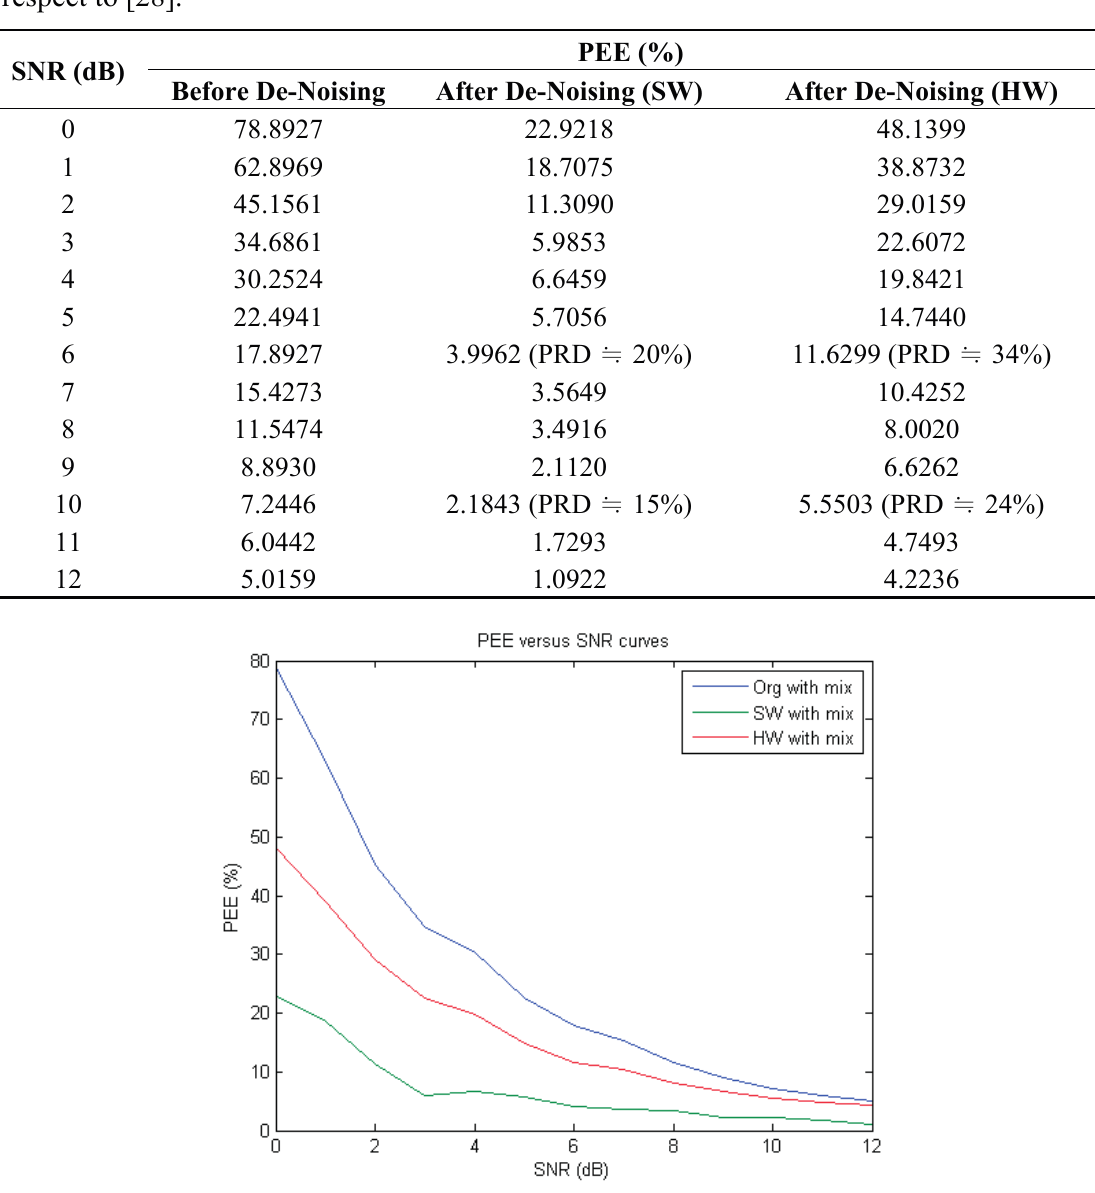
Table 2. SNR versus the PEE values obtained before applying wavelet de-noising, after applying software- and hardware-based wavelet de-noising, respectively, i.e ., the numerical results as shown in Figure 17. Similarly, we here also included the PRDs when SNR levels were at 6 dB and 10 dB, respectively, for performance comparison with respect to [28].